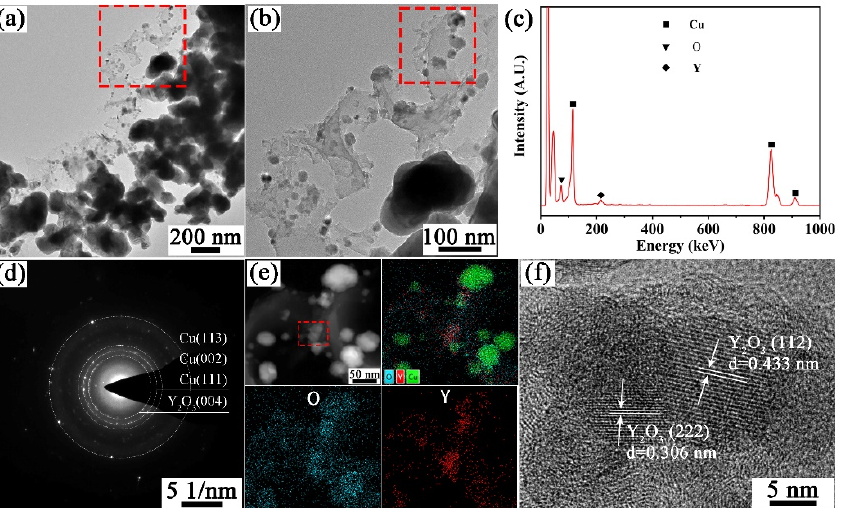
Figure 3. TEM images of hydrogen-reduced Cu-1wt%Y 2 O 3 powders at 400 °C for 1h, ( a , b ) TEM bright field images, ( c ) EDS results of the reduced powders, ( d ) SAED patterns of ( a ), ( e ) element mapping of the rectangular area in ( b ), and ( f ) HRTEM of Y 2 O 3 particles indicated by the rectangle in ( e ).